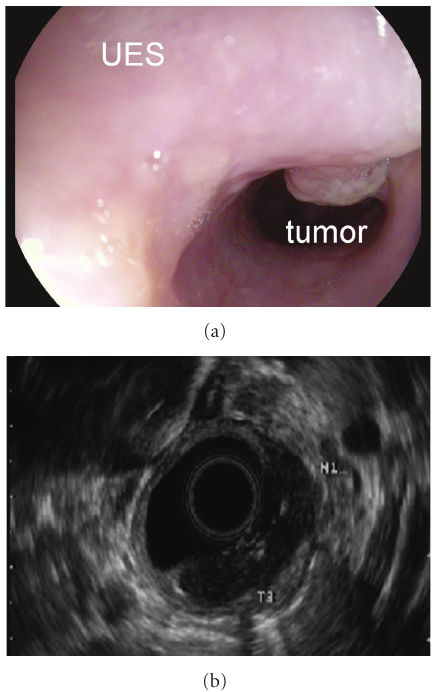
Figure 1: (a) Upper endoscopy highlights the close proximity of the tumor to the upper esophageal sphincter (UES). (b) Endoscopic ultrasound shows invasion of the tumor into the muscularis propria and suspicion for regional node involvement.